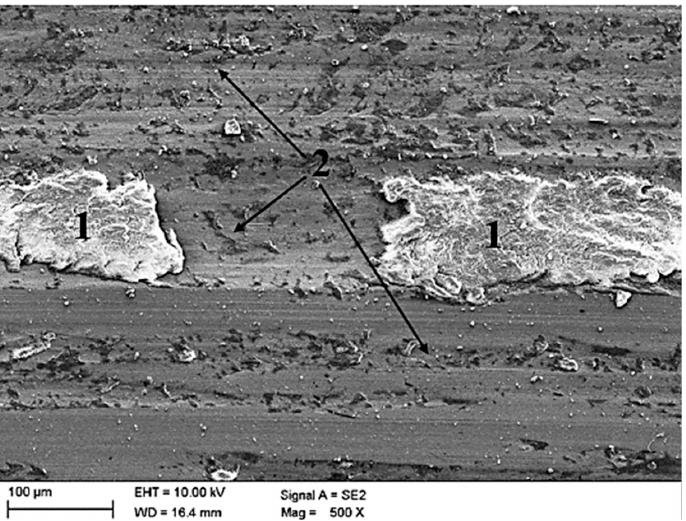
Energies 2021 , 14 , x FOR PEER REVIEW Figure 7. Steel sample surface after the wear tests; 1—kaolinite; 2—scratches. Figure 7. Steel sample surface after the wear tests; 1—kaolinite; 2—scratches.